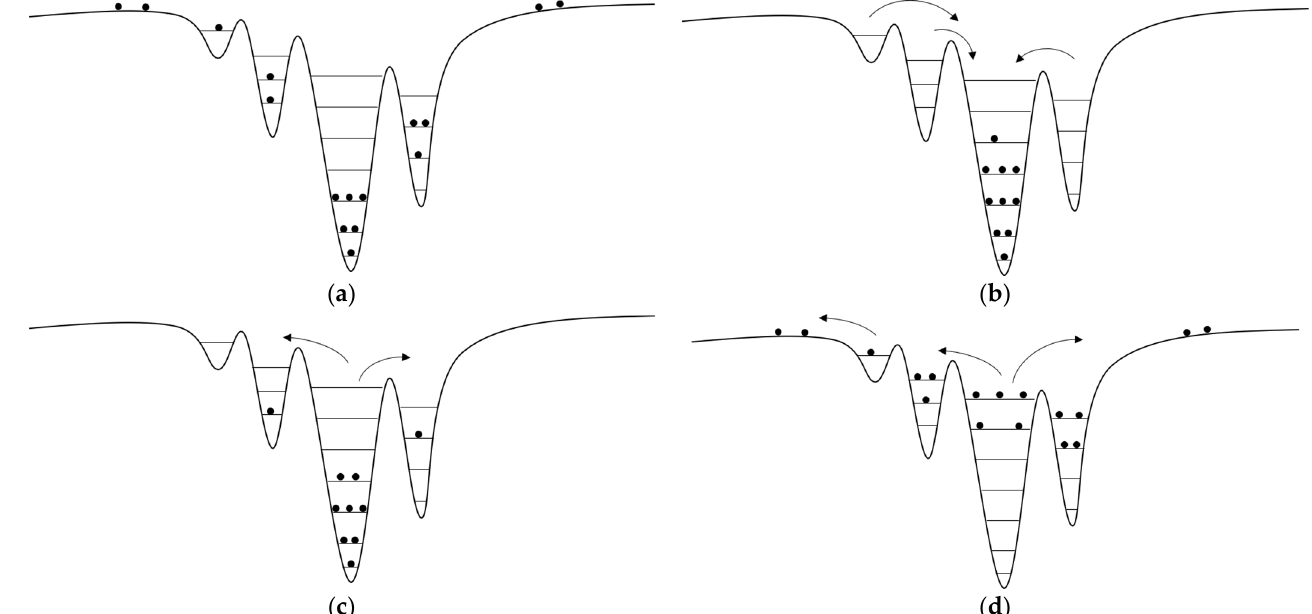
Figure 8. Schematic diagrams illustrating the possible mechanism of the S-shaped temperature-dependent PL peak energy. ( a ) At the lowest temperature, carriers exist in all possible potential minimums. ( b ) At a slightly higher temperature, carriers relax to the deepest potentials. ( c ) As the temperature continues to rise, carriers redistribute to higher energies. ( d ) As the temperature rises very high, most carriers escape from the localization potentials.